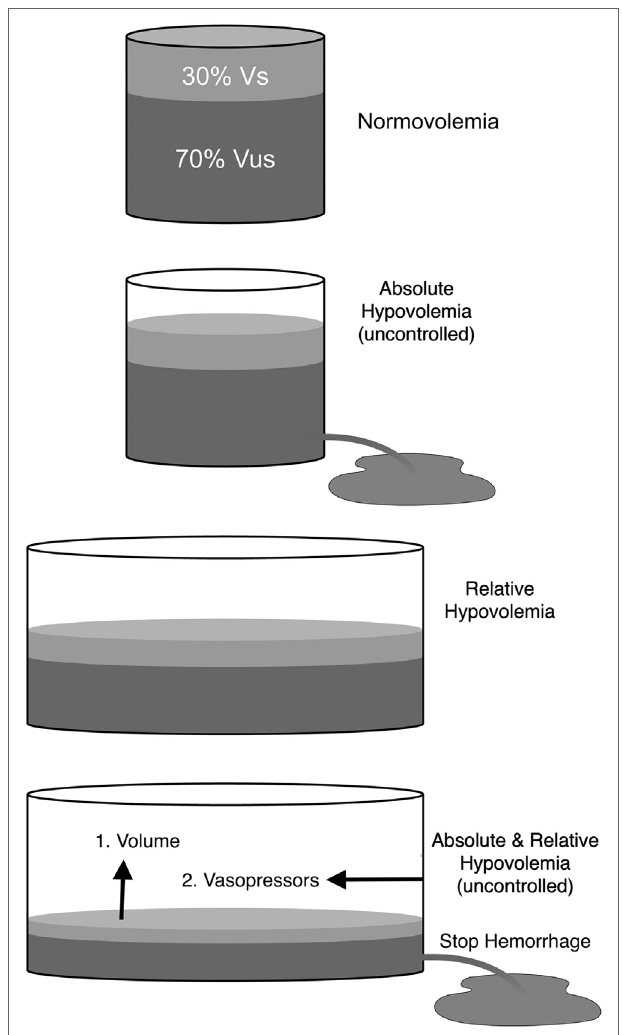
Figure 3 | Schematic representation of total blood volume within the vasculature. Normovolemia: blood volume and vascular capacity are normal. Absolute hypovolemia: blood volume is decreased relative to normal vascular capacity (e.g., hemorrhage). Absolute hypovolemia is either uncontrolled (volume loss continues) or controlled (volume loss has been stopped). Relative hypovolemia: blood volume is normal, increased or decreased, but vascular capacity is increased (e.g., anesthetic overdose; sepsis). Absolute hypovolemia is treated with fluids (e.g., crystalloids; blood). Relative hypovolemia is treated primarily with fluids and vasopressors. Vs, stressed circulating blood volume; Vus, unstressed intravascular